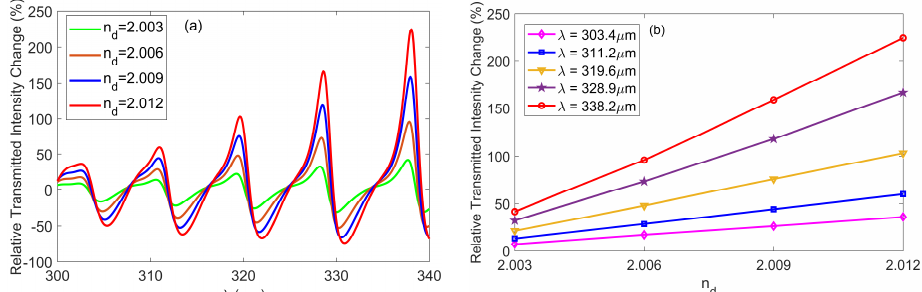
Figure 7. ( a ) Relative transmitted intensity change versus wavelength λ for different n d . ( b ) Maximal value of relative transmitted intensity change as a function of n d at a different destructive wavelength.